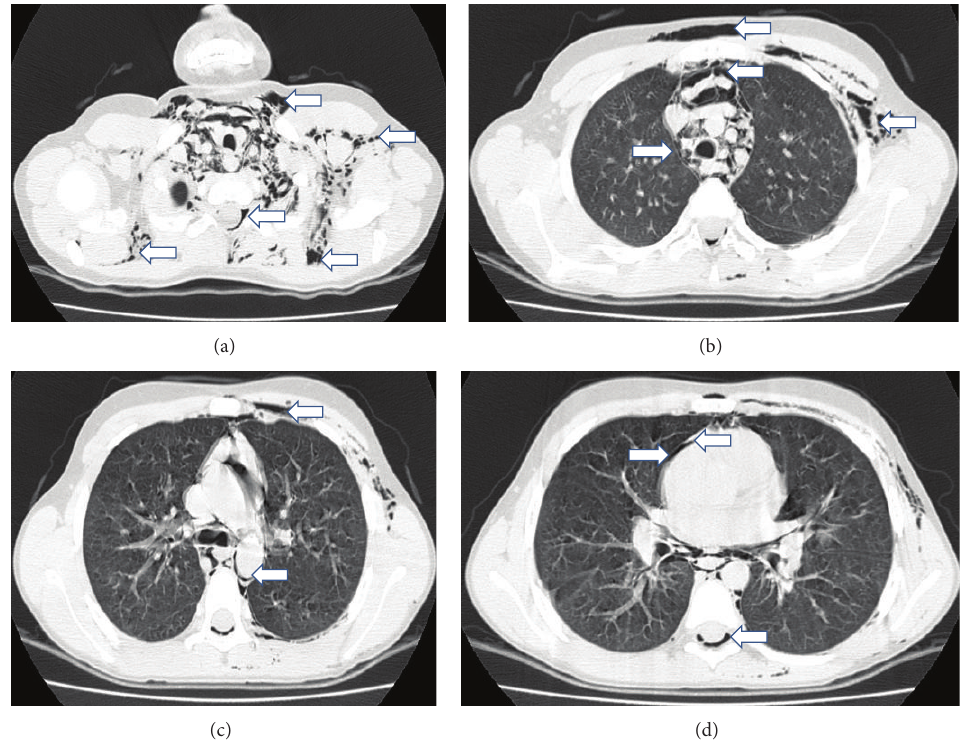
Figure 2: Chest computed tomography of the patient. (a) Free air in the soft tissues of the neck, subcutaneous emphysema, and air in epidural space of cervical vertebra. (b) Subcutaneous emphysema in the soft tissues of the left hemithorax and anterior chest wall as well as mediastinal emphysema surrounding mediastinal structures. (c) Free air surrounding mediastinal vascular structure and subcutaneous emphysema. (d) Pneumopericardium and air in the epidural space of the thoracic